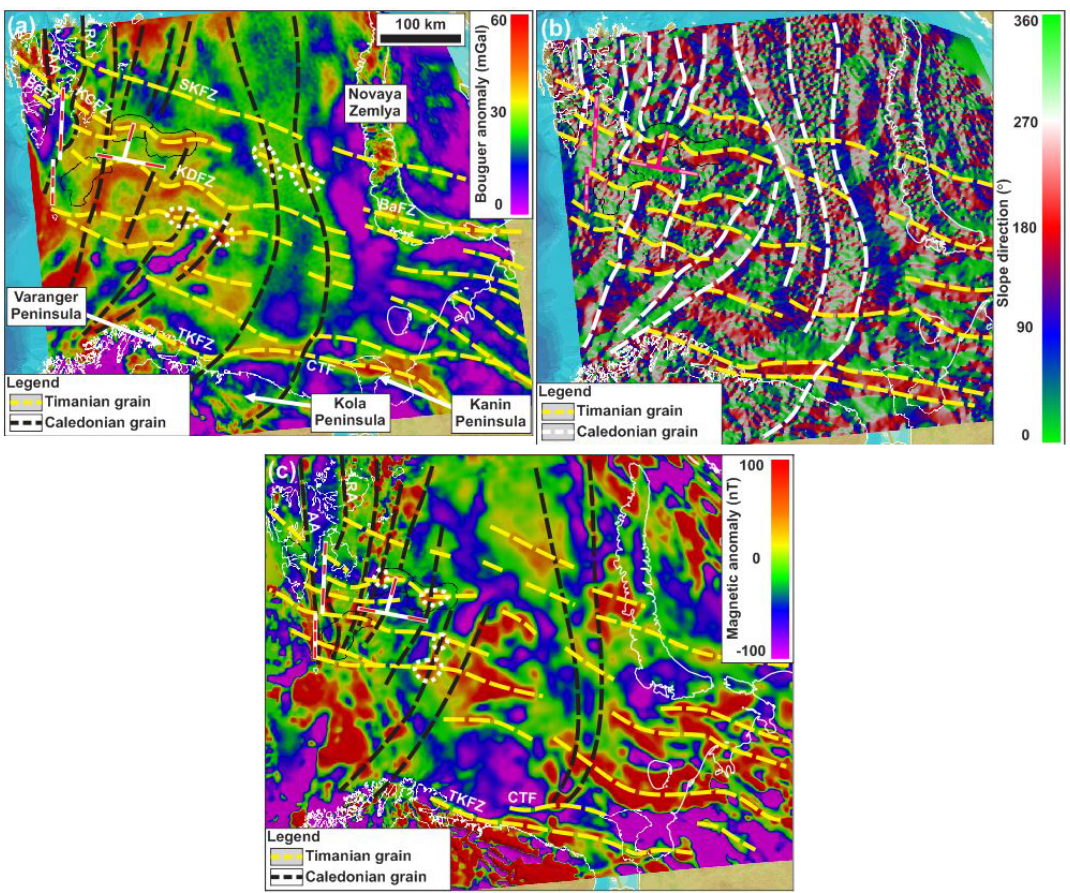
Figure 5. Gravimetric ( a and b ) and magnetic (c) anomaly maps over the Barents Sea and adjacent onshore areas in Russia (see location as a dashed white frame in Fig. 1b), Norway, and Svalbard showing E–W- to NW–SE-trending anomalies (dashed yellow lines) that correlate with the proposed NNE-dipping Timanian thrust systems in Svalbard and the northern Norwegian Barents Sea. Note the high obliquity of E–W- to NW–SE-trending Timanian grain with NE–SW- to N–S-trending Caledonian grain (dashed black and white lines). Note that dashed lines in (a) and (c) denote high gravimetric and magnetic anomalies. Also notice the oval-shaped high gravimetric and magnetic anomalies (dotted white lines) at the intersection of WNW–ESE- and N–S- to NNE–SSW-trending anomalies in (a) and (c) resulting from the interaction of the two (Timanian and Caledonian) thrust-and-fold trends. The locations of seismic profiles presented in Fig. 3a–d are shown as thick white lines in (a) and (c) and as fuchsia lines in (b) . Within these thick white and fuchsia lines, the location and extent of thrust systems evidenced on seismic data (Fig. 3) are shown in white in (a) and (c) and in pink in (b) . For the E–W-trending seismic profile shown in Fig. 3b, this implies that the red and pink lines represent N–S-trending synclines. Abbreviations are as follows. AA: Atomfjella Antiform; BaFZ: Baidaratsky fault zone; BeFZ: Bellsundbanken fault zone; CTF: Central Timan Fault; KCFZ: Kongsfjorden–Cowanodden fault zone; KDFZ: Kinnhøgda–Daudbjørnpynten fault zone; RA: Rijpdalen Anticline; SKFZ: Steiløya–Krylen fault zone; TKFZ: Trollfjorden–Komagelva Fault